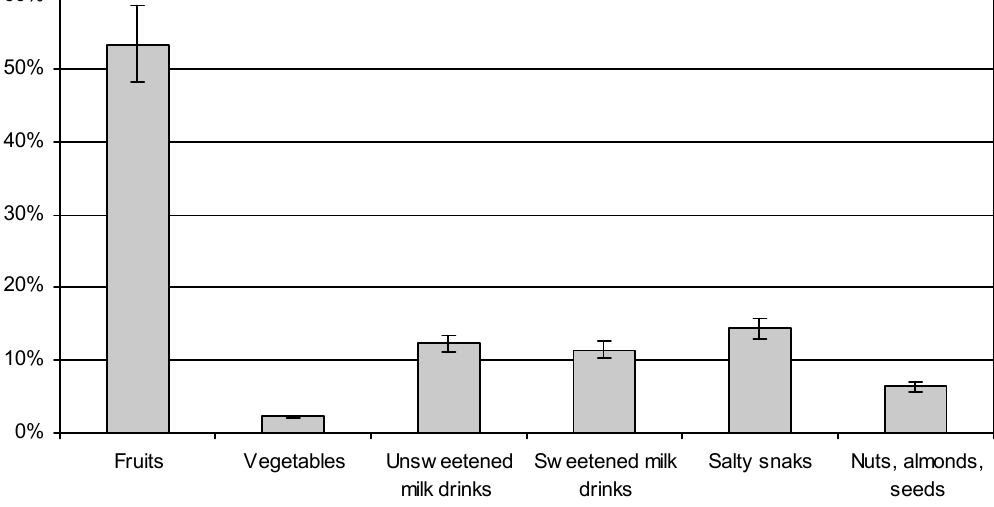
Figure 2. Type of food eaten between main meals by participants.